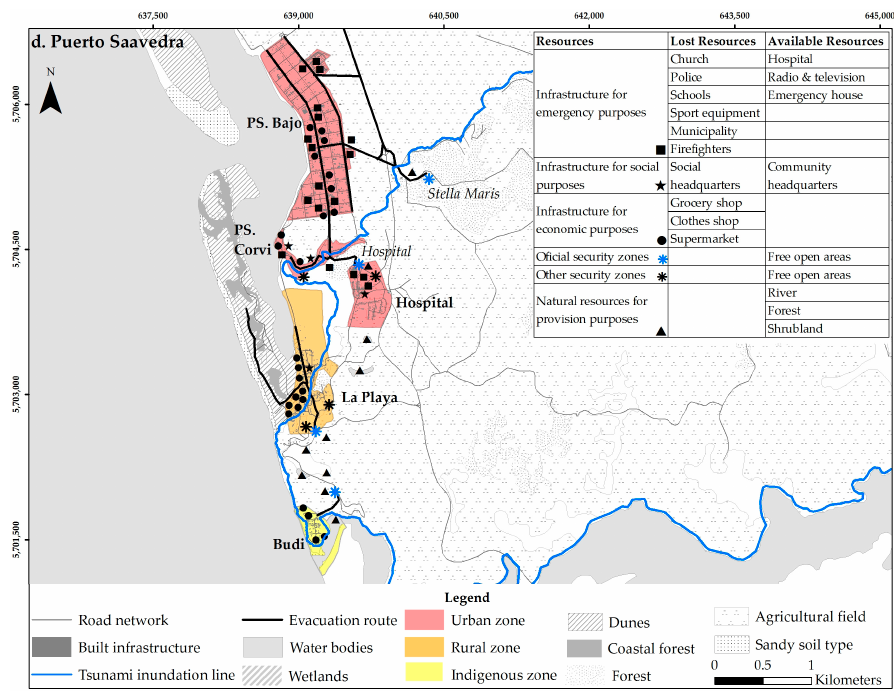
Figure 1. ( a ) Study town of Mehuín; ( b ) Study town of Queule; ( c ) Study town of La Barra; ( d ) Study town of Puerto Saavedra. Note: These maps show the urban, rural and indigenous areas of each study town, and indicate official security zones and evacuation routes. In addition, the available and lost resources after tsunami are mapped considering their location below and above the tsunami inundation line [26]. Sources: Civil Protection Plan in case of Tsunami 2013, Land Use Plans of Saavedra 2013 and Toltén 2012, and fieldwork on site.